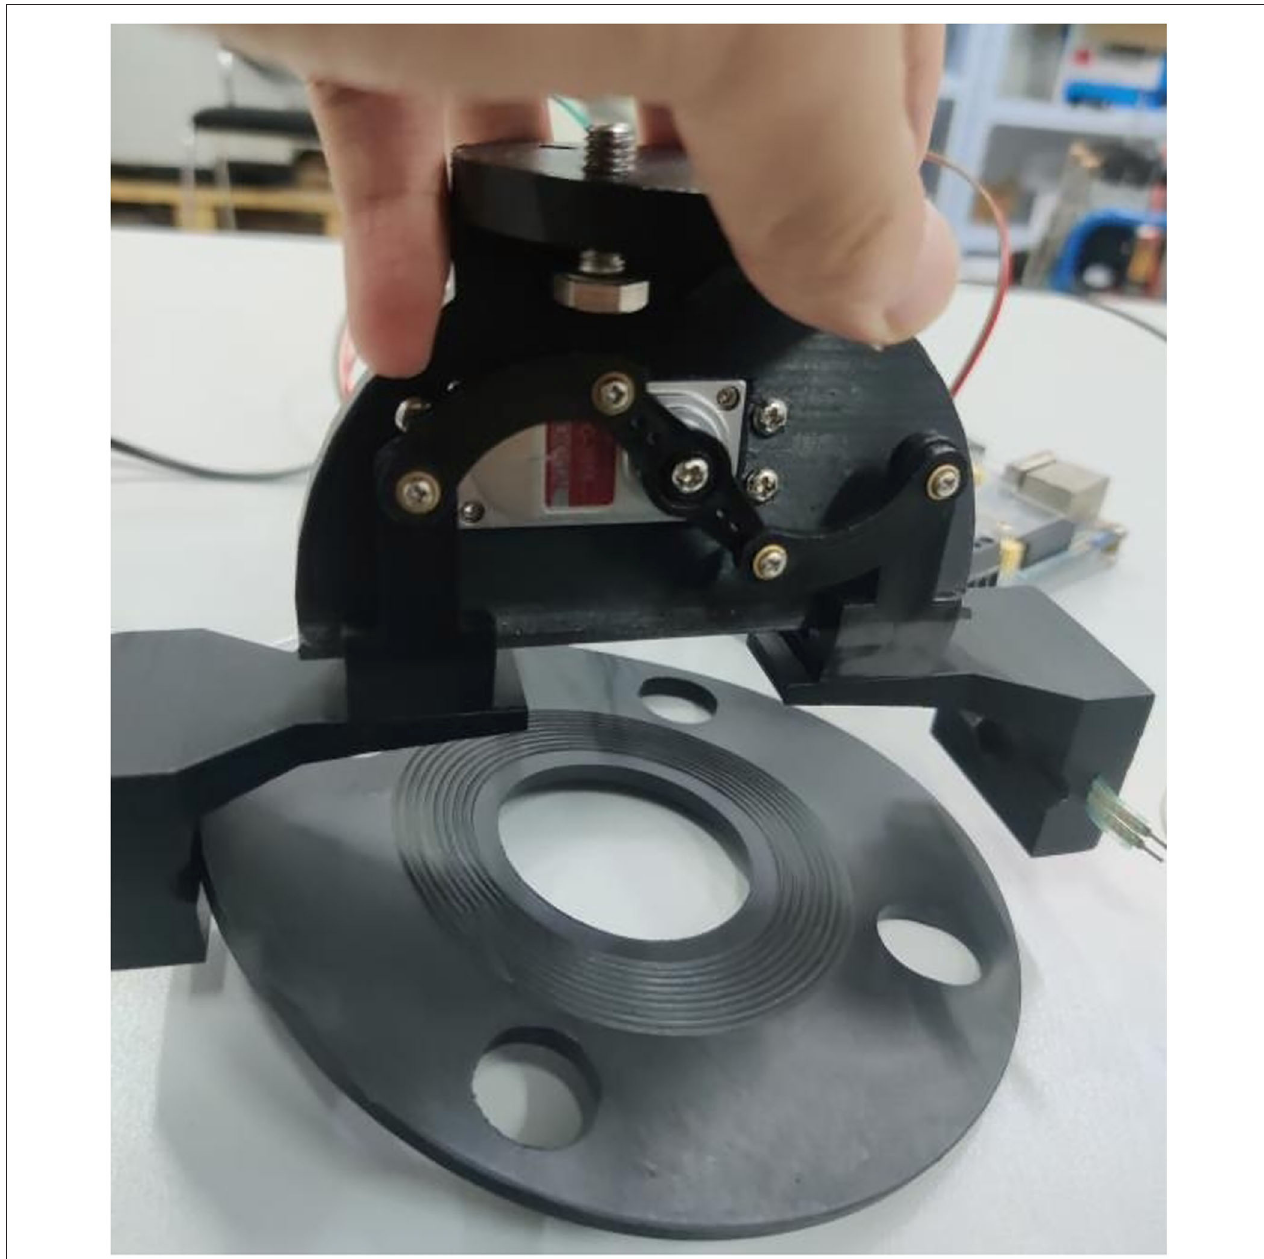
FIGURE 7 | The slippage effect picture of the gasket during the grasping test.